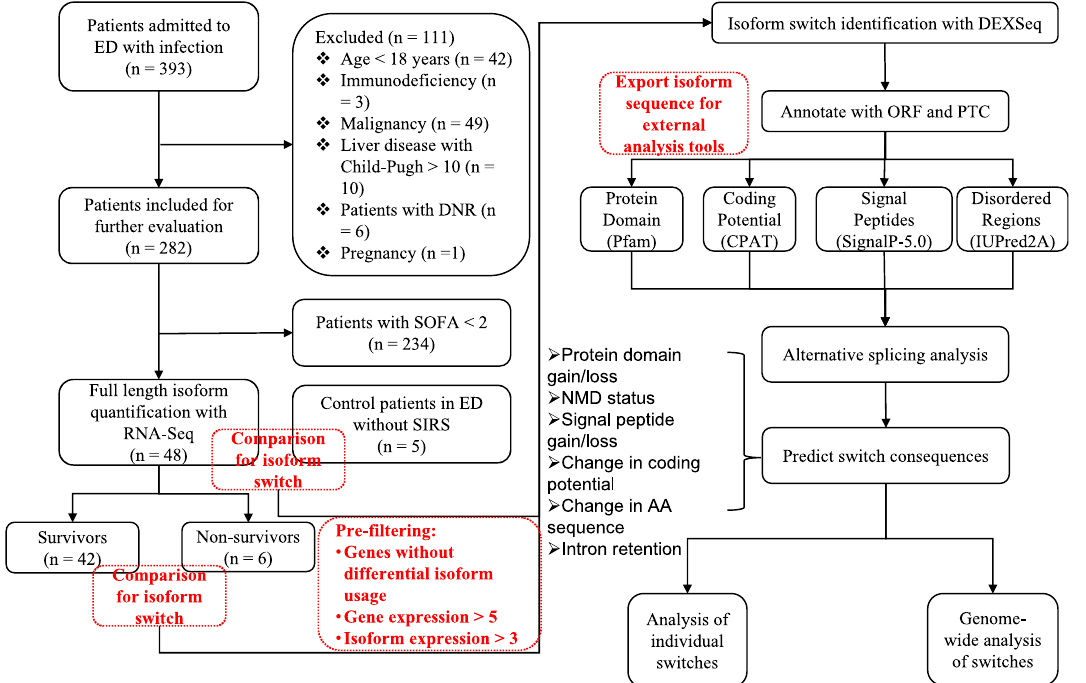
Figure 1. Schematic illustration of the workflow. A total of 393 patients were screened during the study period. After application of the exclusion criteria, 48 patients with sepsis were included for RNA-Seq and subsequent analyses. Isoform switching between patients with and without sepsis and between nonsurvivors and survivors was tested using the DEXSeq algorithm. The sequences of the isoforms were then annotated as ORFs and PTCs. The consequences of isoform switching, such as coding potential, protein domain, intrinsically disordered regions (IDR) and intrinsically disordered binding regions (IDBR), were predicted with external tools. The possibility of alternative splicing was also determined for each case of each isoform switching. Switching can also be analyzed at the individual and genome-wide levels. The gene expression > 5 and isoform expression > 3 was measured in FPKM. ED emergency department, DNR do not resuscitate, SOFA sequential organ failure assessment, ORF open reading frame, PTC pre-mature termination codons, NMD Nonsense Mediated nonsurvivors (6/6 vs. 36/42; p = 0.004). Nonsurvivors showed significantly more MV days than survivors (17.5 (6.3, 26.5) vs. 1.5 (0, 7.0) days; p = 0.042, Table 1). Isoform switching in patients with sepsis versus controls. The case of isoforms switching compared to non-sepsis controls varied across sepsis types (classified by infection site). Patients with abdominal infections exhibited the largest number of genes undergoing isoform switching with functional consequences, as well as the fraction of genes passed filtering criteria for isoform switching, followed by patients with urinary tract, brain, and lung infections (Fig. 2A,B). The number of genes with significant isoform switching with predicted functional consequences that were common to all sepsis types was very small, indicating heterogeneity across sepsis types (Fig. 2C). Compared to the controls, the patients with sepsis consistently showed significant isoform switching of the FLOT2, LRG1 and MEGF9 genes (Fig. 2D). The number of genes with isoform switching conse- quences was generally consistent across sepsis types. However, there was also heterogeneity across sepsis types: patients with intestinal sepsis had fewer isoform switching genes with coding potential, and patients with lung sepsis showed greater IR loss (Fig. 3A). There was less IR gain than loss in patients with abdomen, brain, lung and soft tissue sepsis. There were more A3 and A5 gains in the patients with abdominal sepsis than in the con- trols (Fig. 3B). The four types of sepsis were consistently associated with more IR loss than gain. Furthermore, there was a significant difference in A5 gain between the patients with urinary tract and those with abdominal sepsis, with patients with abdominal sepsis more likely to show A5 gain, and those with urinary tract sepsis were less likely to have A5 gain. There was significant uneven distribution of opposite switching consequences (Fig. 3C). Abdomen sepsis was more likely to have A5 gain than the urinary sepsis (Fig. 3D,E). Isoform switching was further explored by combining all sepsis types together (Additional File 2). Genes with different isoforms included FLOT2, LRG1, HLA-B and MEGF9 (Fig. 4A). The relationship between isoform switch and differential expression was explored. Many genes without differences in gene expression showed significant isoform switching (Fig. 4B). The most frequent changes were those affecting ORFs, protein domains and IR (Fig. 4C,D). Notably, the opposite consequences were not evenly distributed, e.g., more IR loss than IR gain (Fig. 4E). There were fewer IR and ATTS gains in the patients with sepsis than in the controls (Fig. 4F). After FDR correction of these comparisons, none of the differences were significant.